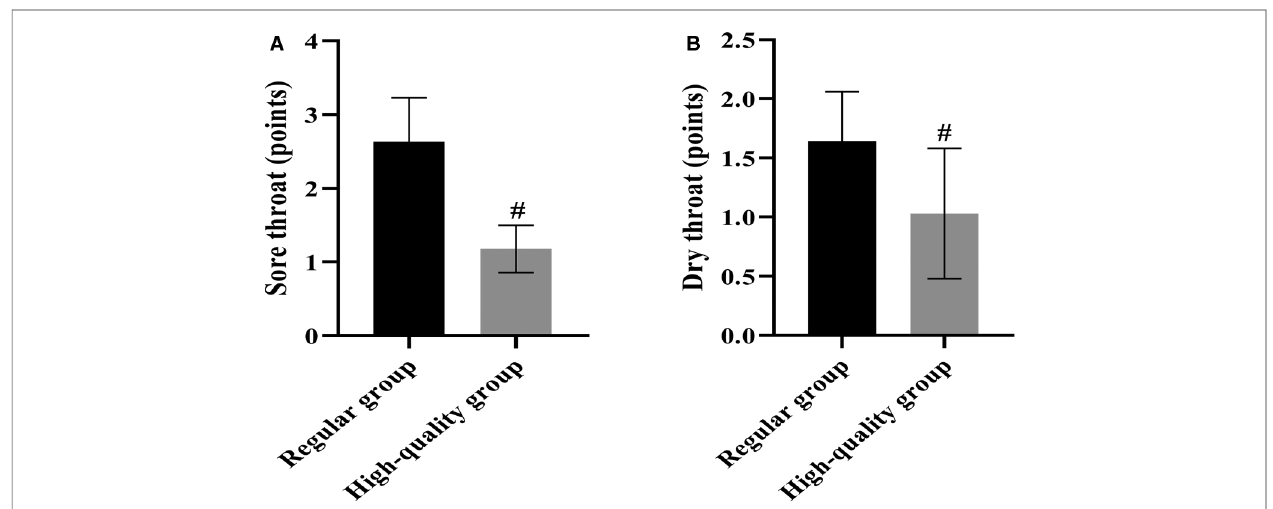
FIGURE 1 | Comparison of the severity of postoperative pharyngeal complications between the two groups (Mean, SD). Note: ( A ) shows the sore throat score and ( B ) shows the dry throat score. # shows the difference with the Regular group, p